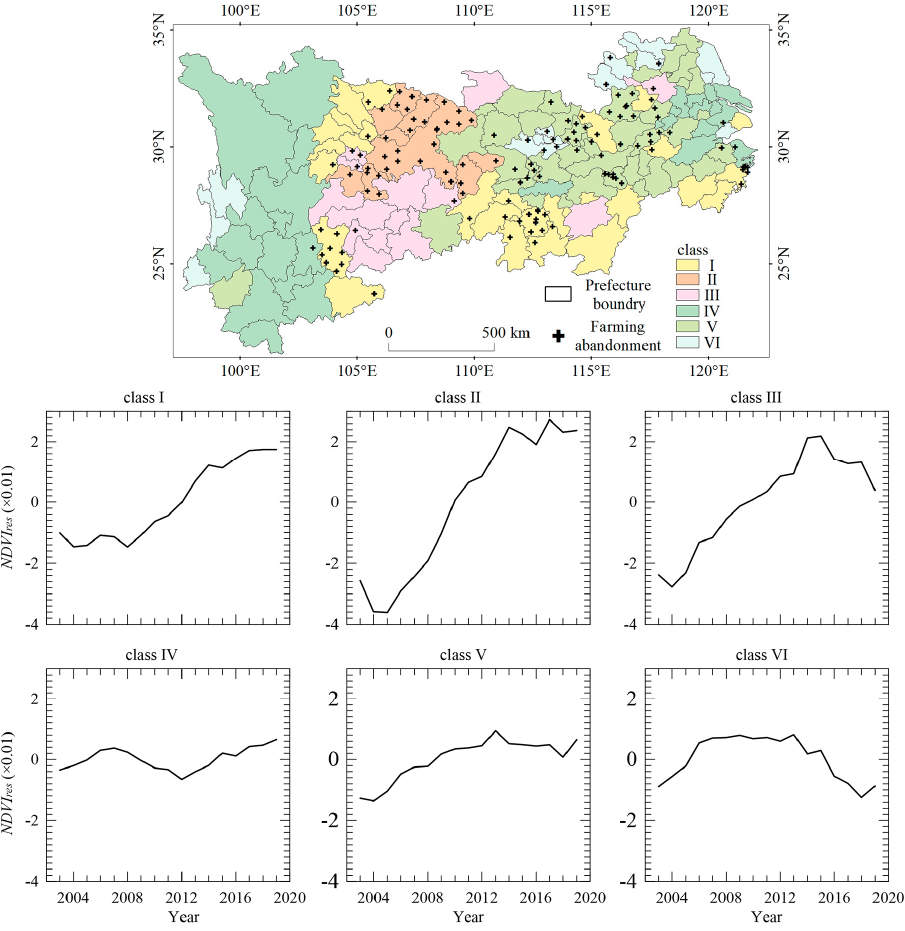
Figure 10. The same as Figure 9 but for the NDVI res serials from 1982 to 2003, as well as with black crosses in the top panel indicating cropland abandonment from 1992 to 2017 [39].